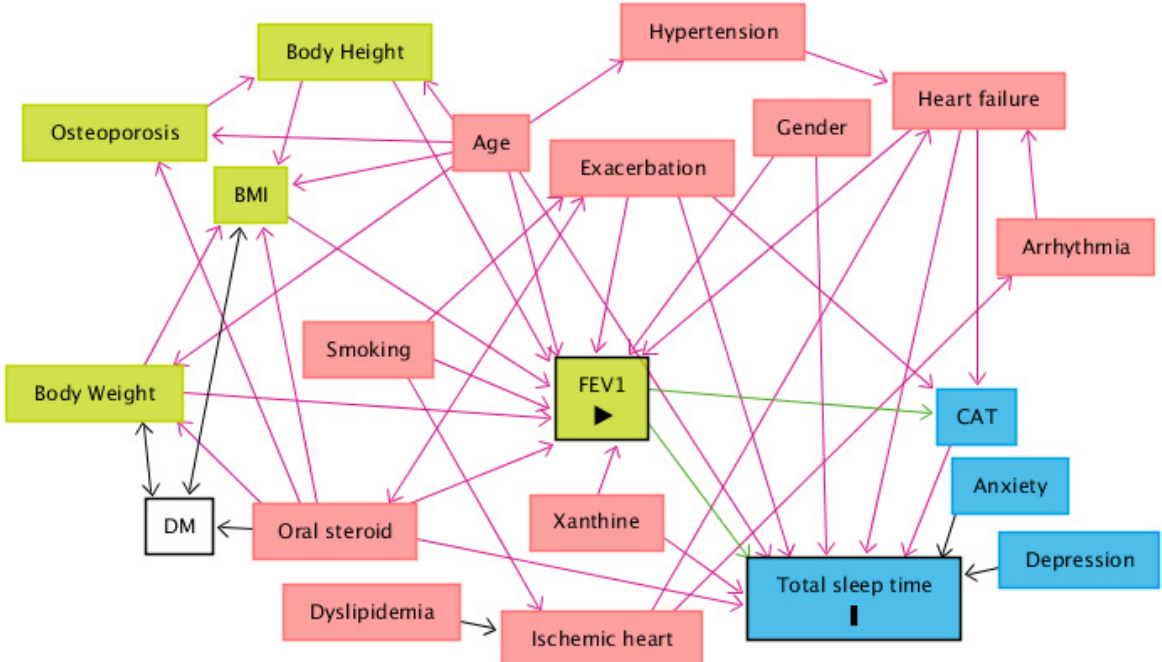
Figure 3. A directed acyclic graph (DAG) was drawn to identify the minimum set of confounders. The minimal sufficient adjustment sets for estimating the direct effect of FEV 1 on total sleep time are age, CAT, exacerbation, gender, heart failure, oral steroids and xanthine. Abbreviations: BMI = body mass index; CAT = COPD Assessment Test; DM = diabetes mellitus; FEV 1 = forced expiratory volume in one second. Legends: green square = ancestor of exposure; blue square = ancestor of outcome; pink square = ancestor of exposure and outcome; transparent square = other variables; green arrow = causal path; pink arrow = biasing path.